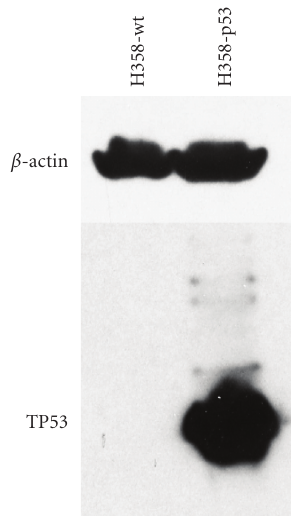
Figure 4: Western blots of cell line H358. There is no detectable TP53 expression in wild-type cells; while transfected cells clearly show TP53